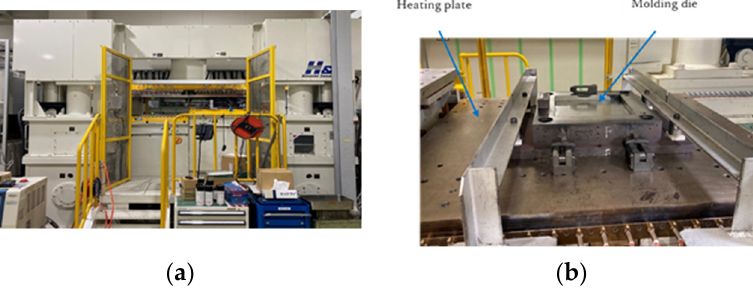
Figure 4. ( a ) Press-molding machine; ( b ) Press-molding die attached to heating